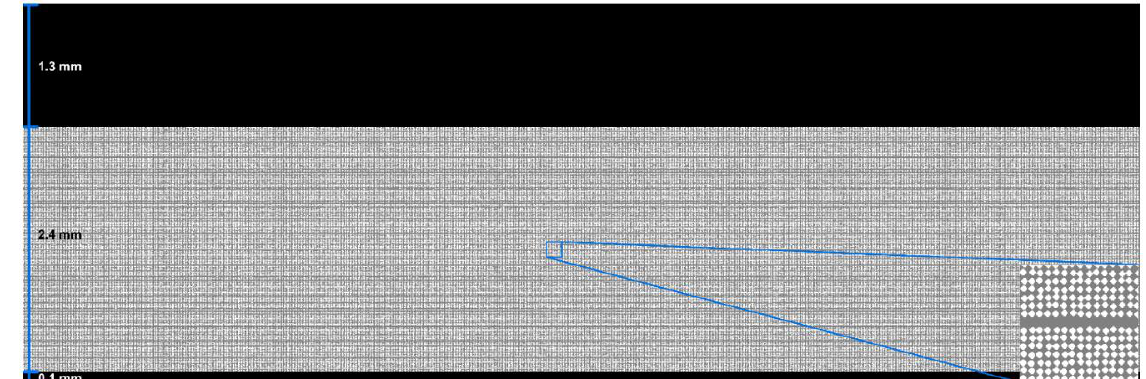
Figure 1. Simulated CFRP composite structure without flaws. The right-bottom panel presents a zoomed image of the pseudorandom carbon fiber (white) distribution in the epoxy (gray) matrix, as well as the ply junction. The black areas correspond to water. Vertical dimensions are indicated on the left side, while the horizontal dimension is 12 mm.